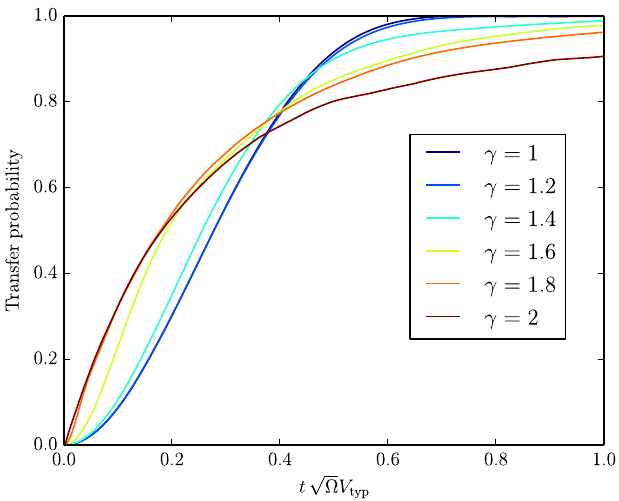
FIG. 28. Population transfer probability as a function of time rescaled with the effective miniband width of states in the miniband is estimated using Fermi ’ s golden rule Ω ¼ M 2 − γ ; see Eq. (100) of the main